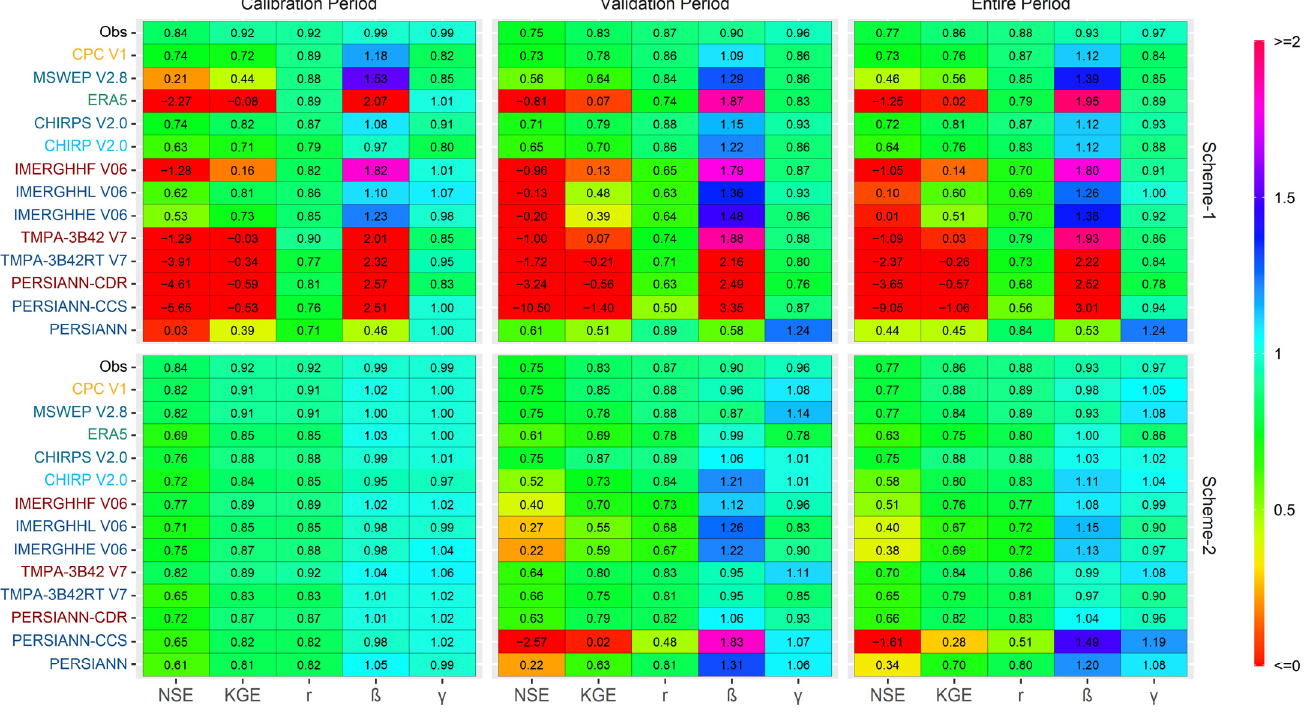
Figure 11. Performance of daily streamflow simulations at the Karasu basin outlet using the gauge and 13 GPDs data considering calibration, validation, and entire period. Y-axis color presents: satellite-based (blue), gauge and satellite (red), reanalysis and satellite (sky blue), reanalysis (green), reanalysis, ground, and satellite (steel blue), and ground (yellow).